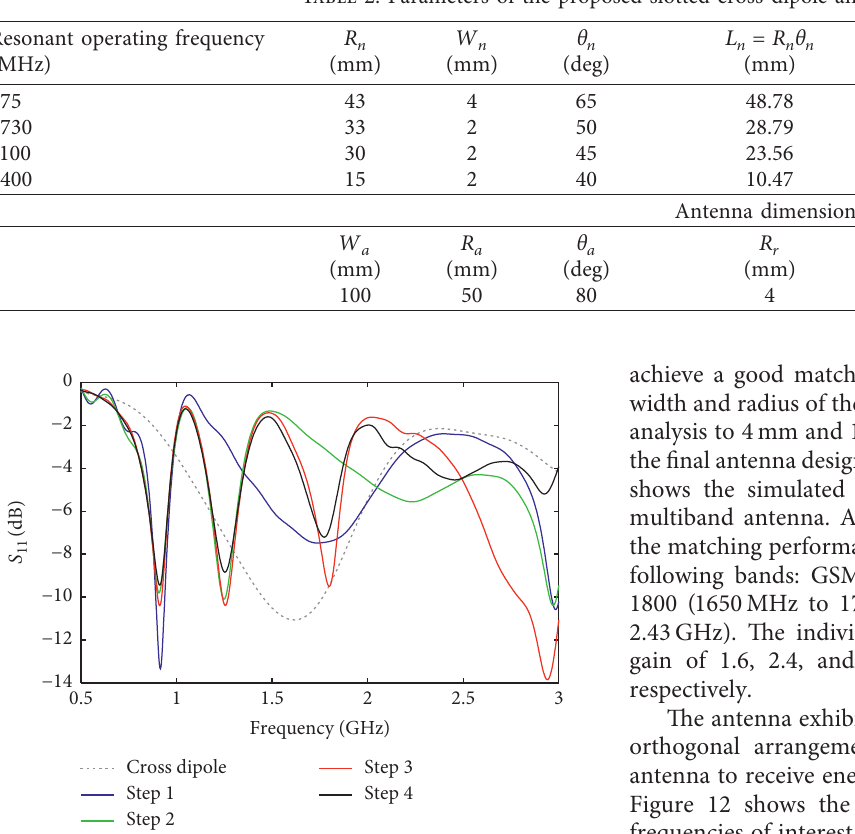
Figure 9: The simulated S quency for different design steps.